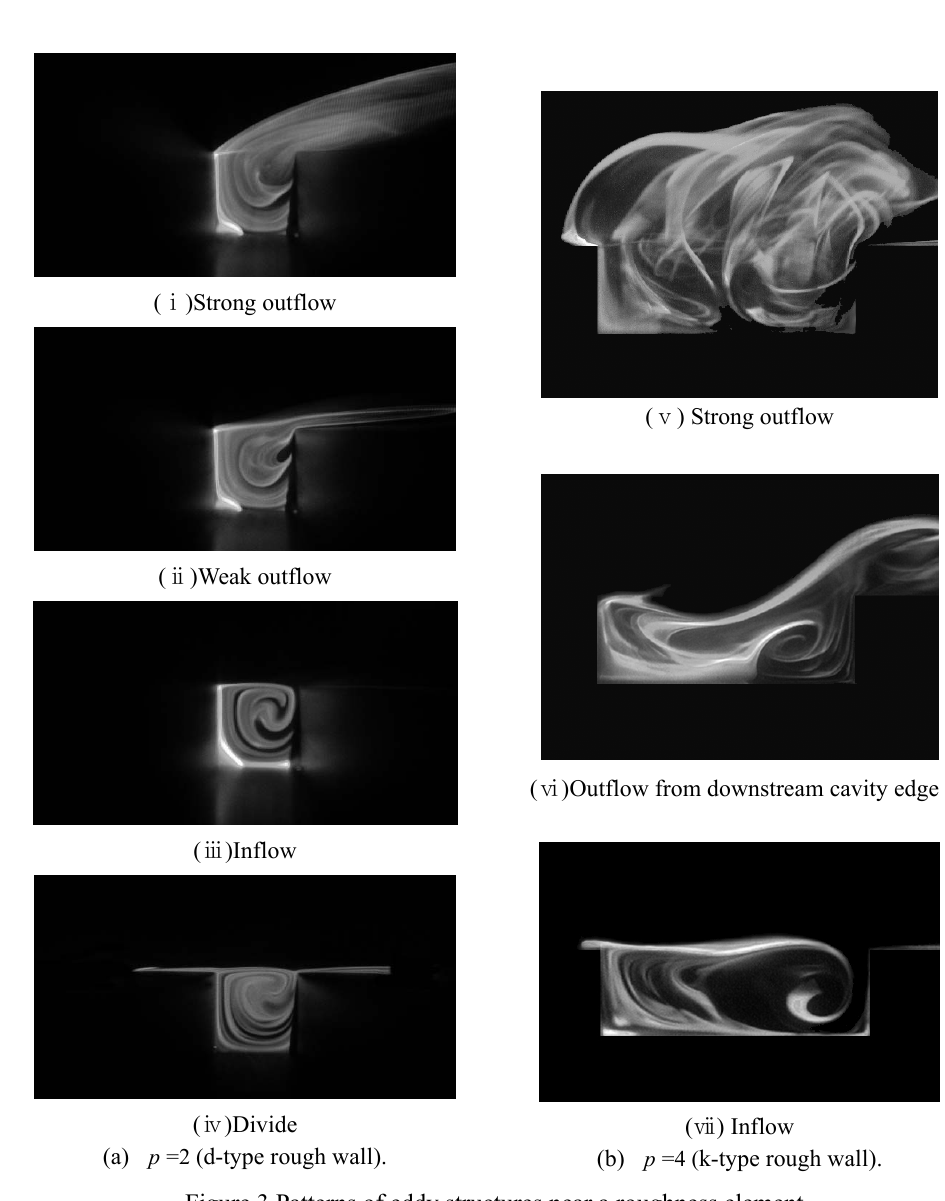
Figure 3 Patterns of eddy structures near a roughness element. (Flow left to